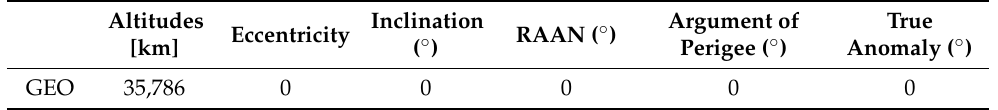
Table 3. GEO Parameter *.